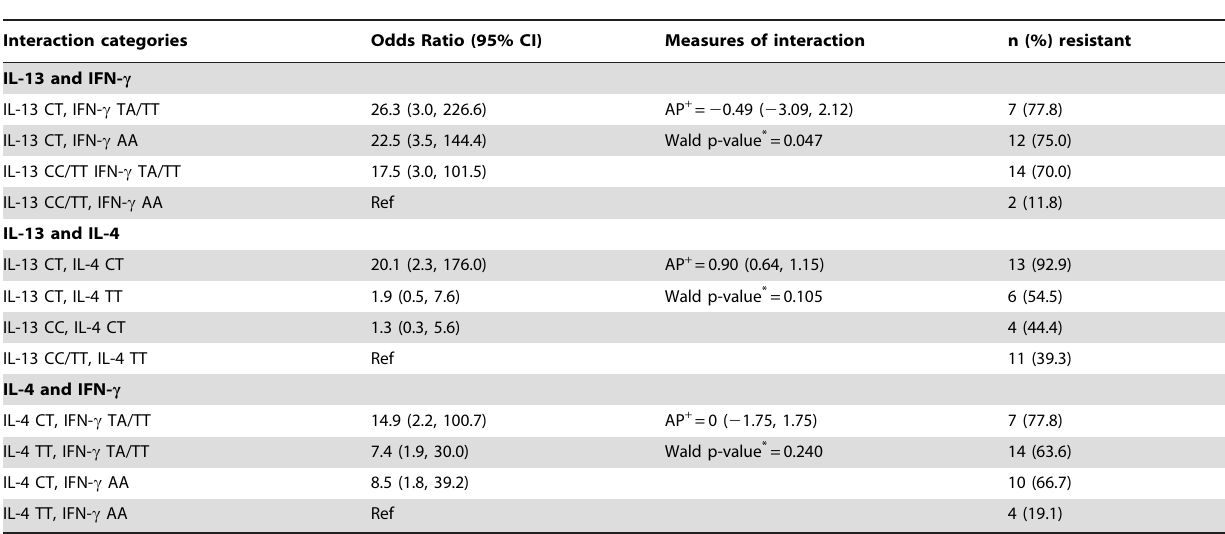
Table 3. Odds ratios for the associations between genotype and resistance within categories of genotype interaction.